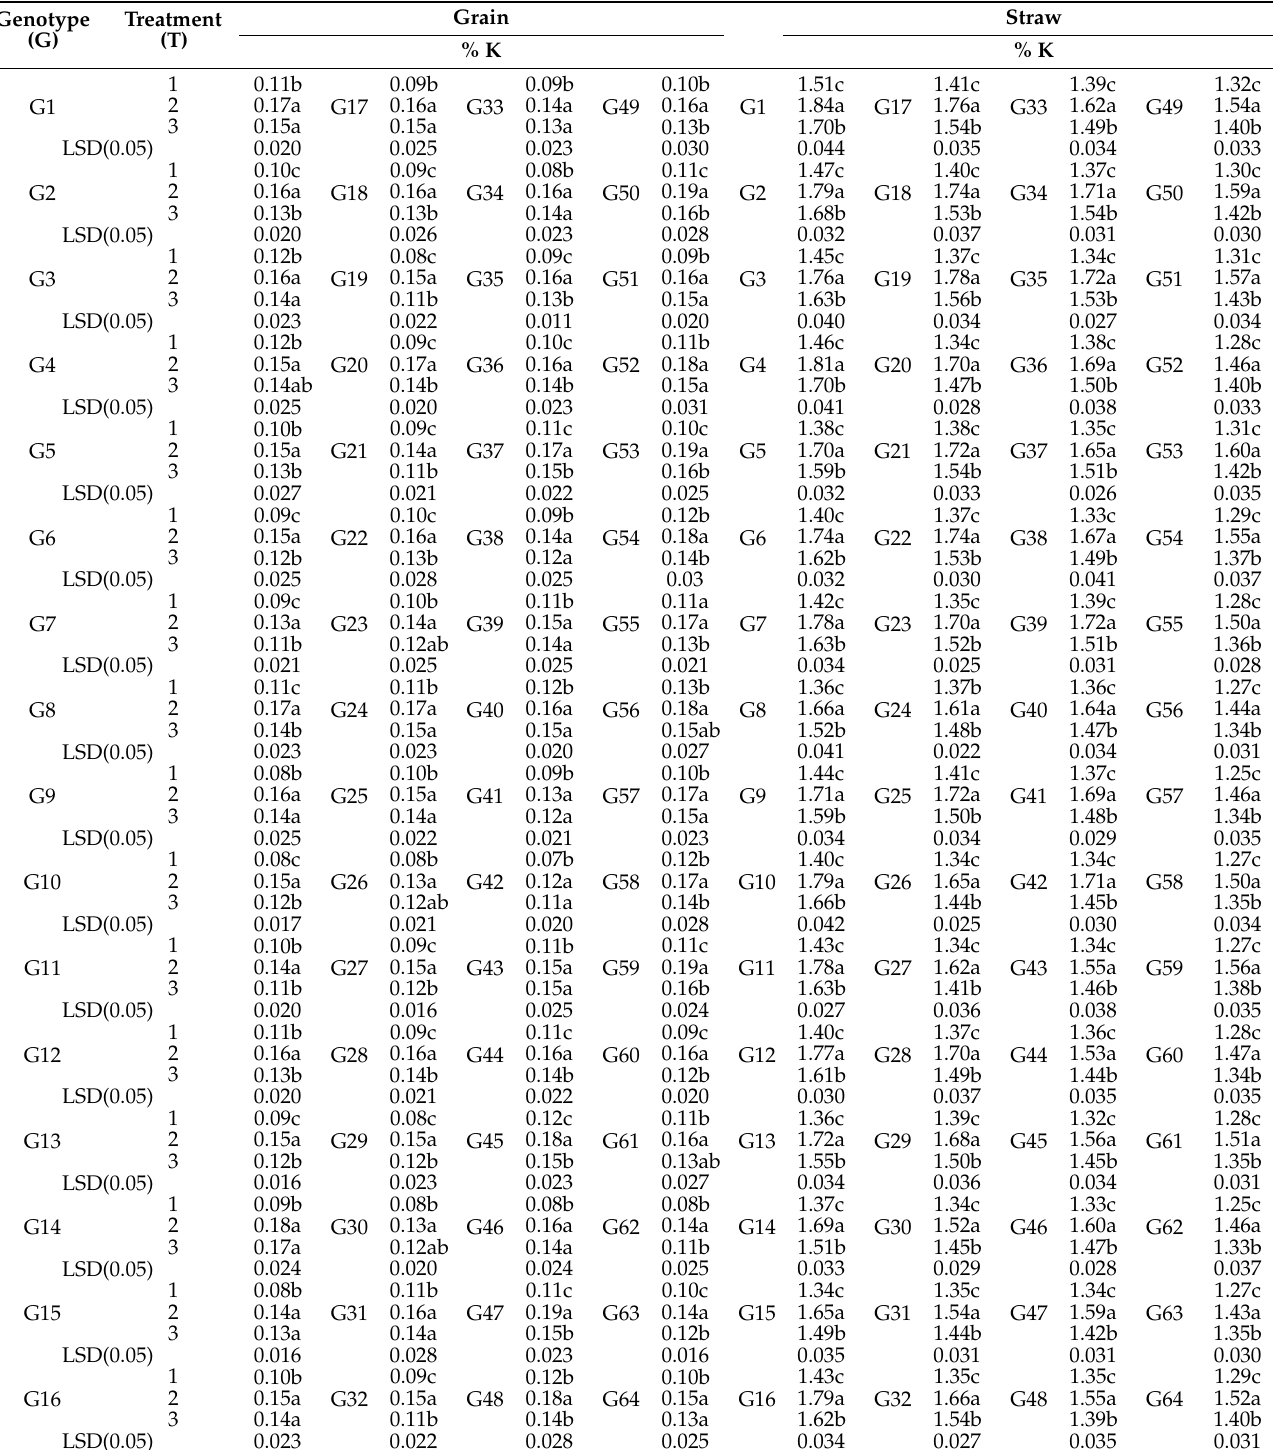
Table 12. Grain and straw nutrient content (% K) of 64 rice genotypes as influenced by treatment and genotype (pooled over two